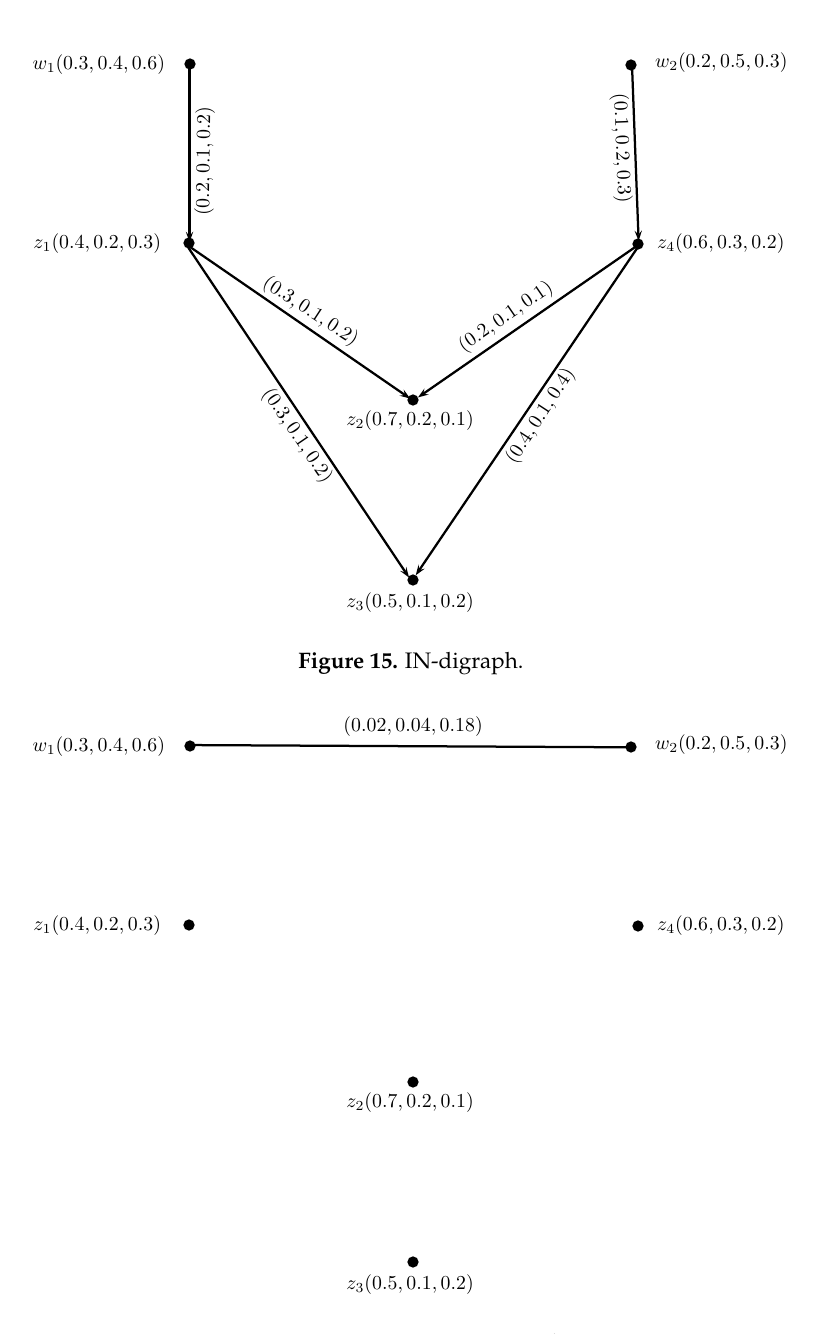
Figure 15. IN-digraph.